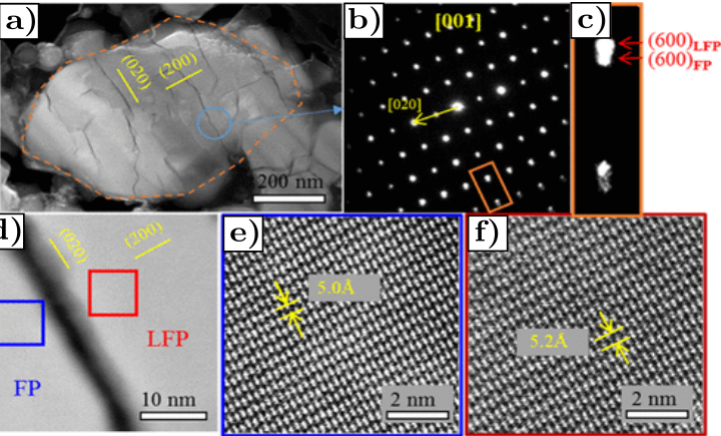
Figure 17. LiFePO 4 and PO 4 phases separated by ac plane cracks in a LFP crystal electrochemically cycled, with ( a ) STEM-HAADF image of the crystal at 100% SOC, ( b , c ) SAED patterns and ( d – f ) STEM- HAADF images. Reprinted with permission by American Chemical Society from [99], Copyright 2020.